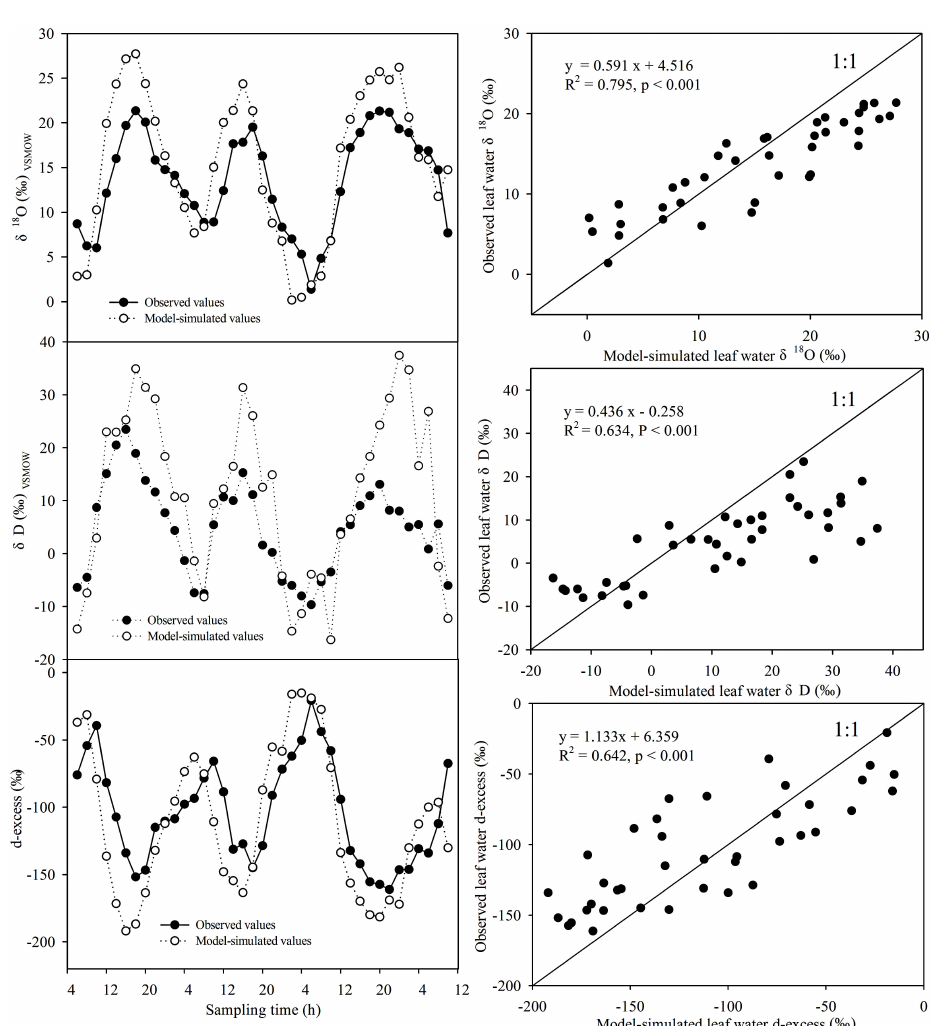
Figure 11. Comparison of leaf water δ 18 O, δ D and d-excess values for Populus euphratica between the simulated values (steady-state Craig–Gordon model) and observed values at